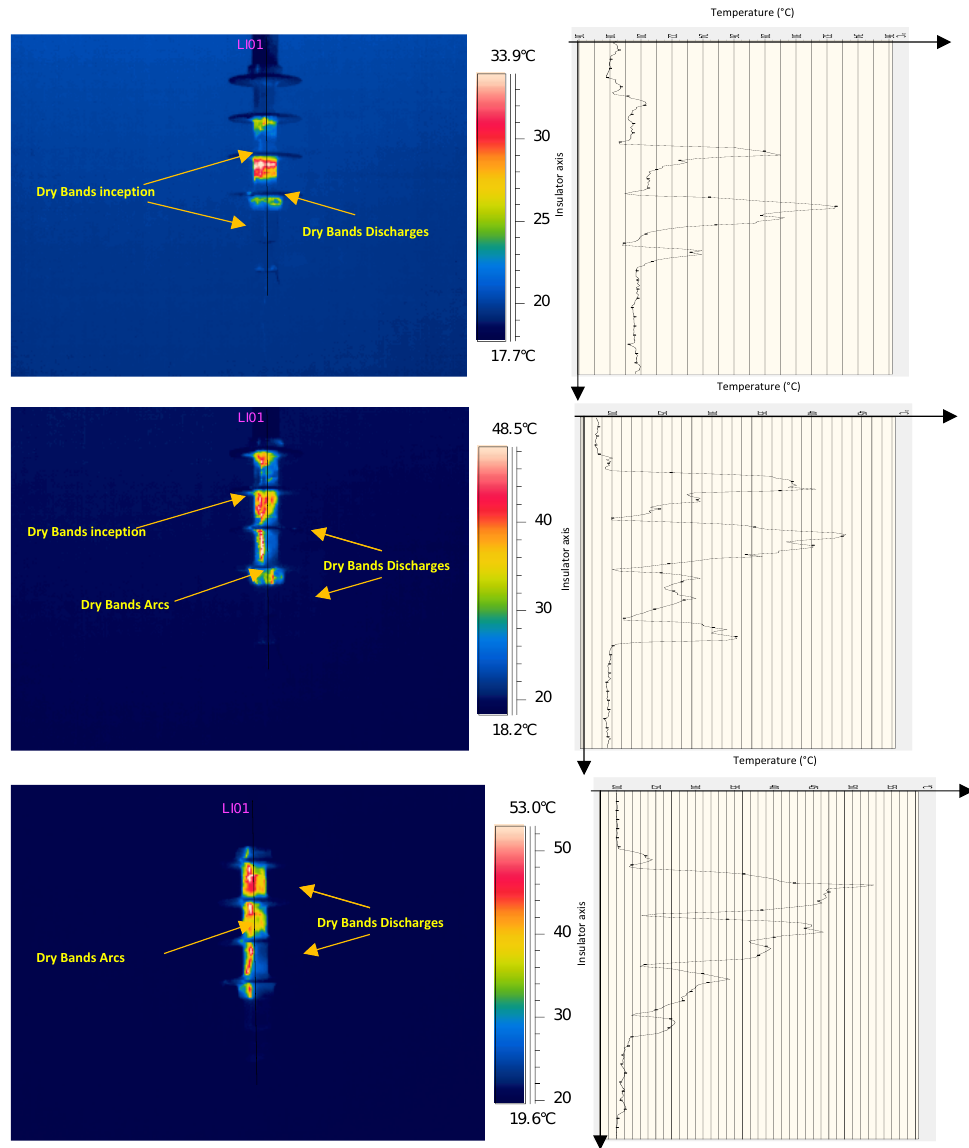
Figure 7. Infrared recording and thermal activity during the FOV test with ESDD 1 = 0.12 mg/cm 2 and NSDD 2 = 0.23 mg/cm 2 .